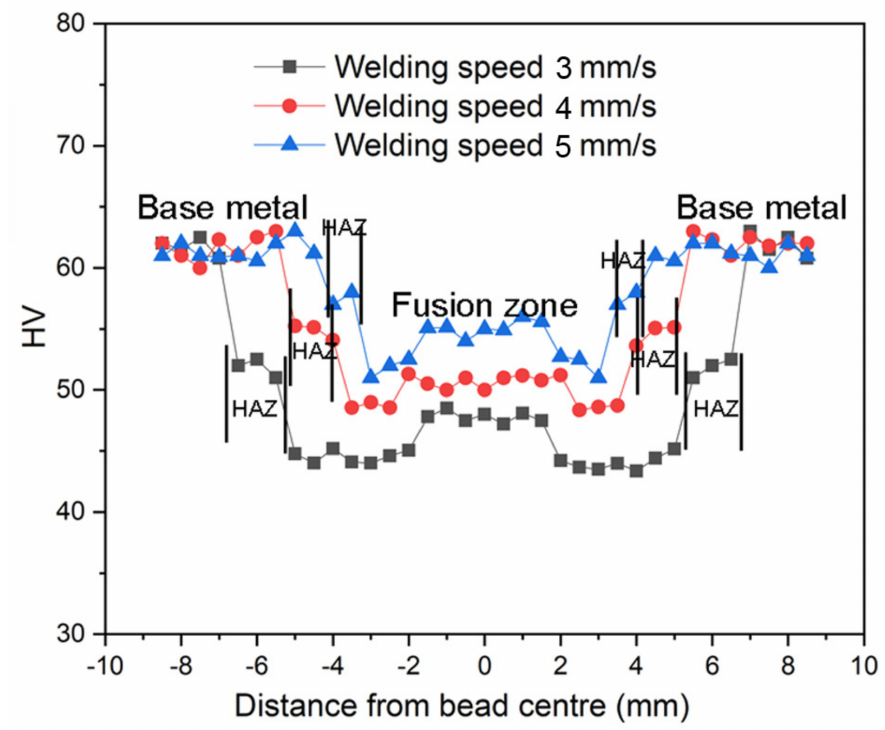
Figure 10. Hardness measurements across the welds were prepared with different welding speeds (3 mm/s, 4 mm/s, and 5 mm/s).